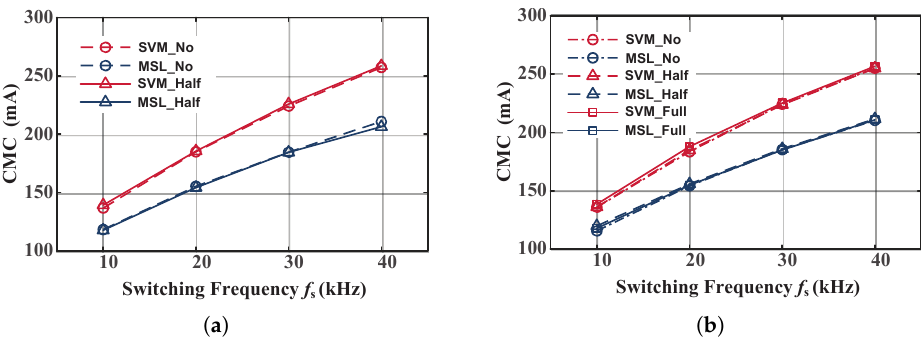
Figure 15. Comparison of the current THD: ( a ) current THD at f o = 25 Hz with no and half load and ( b ) current THD at f o = 50 Hz with no, half, and full load, respectively.